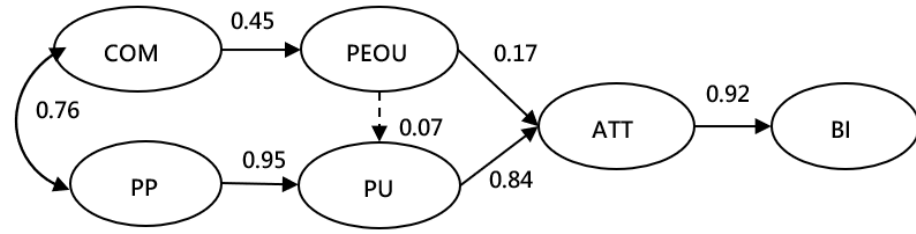
Figure 2. Switch User’s Behavior model results.